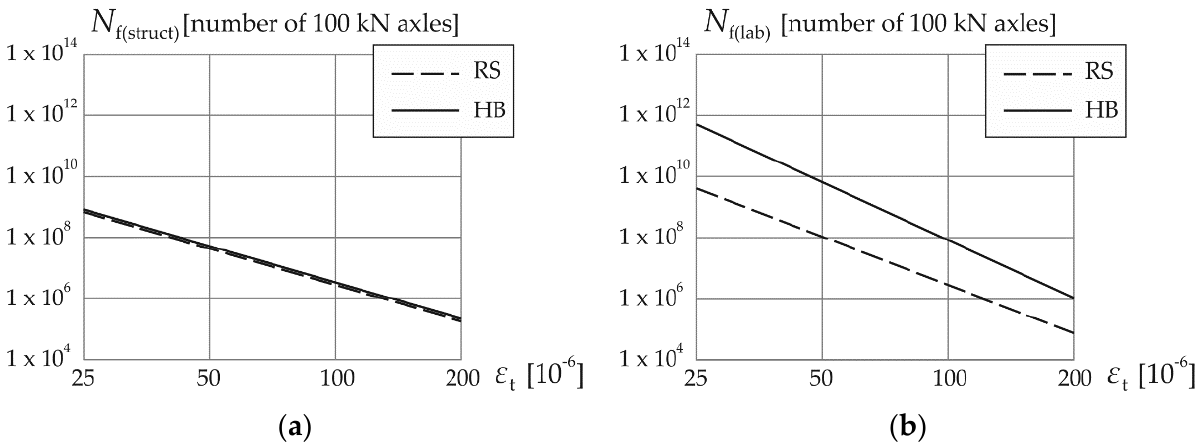
Figure 2. Fatigue curves of the entire structures with asphalt base course fatigue characteristics based on formula (1) and: ( a ) structural method at FC = 5%, ( b ) laboratory method.